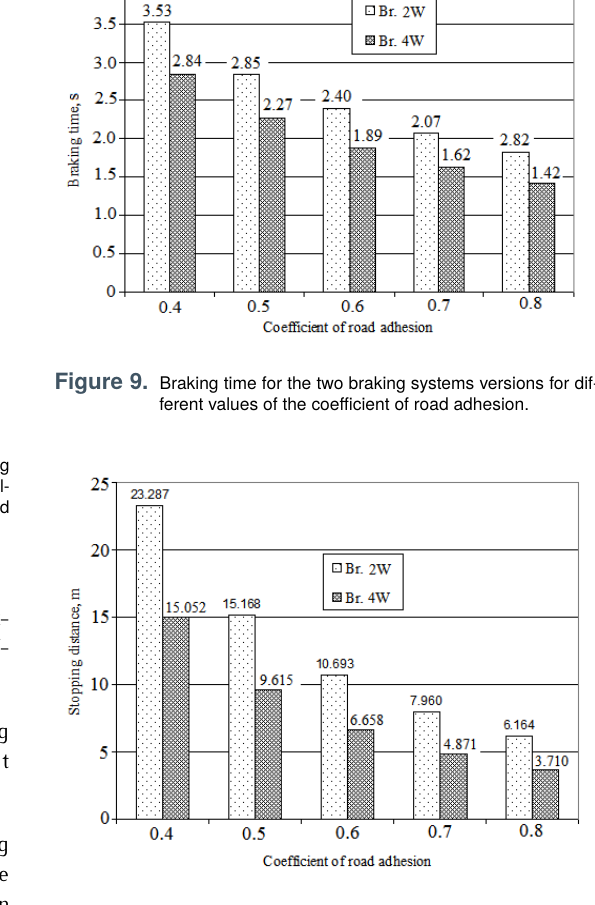
Figure 10. Braking distance (stopping distance) for the two braking systems versions for different values of the coefficient of road